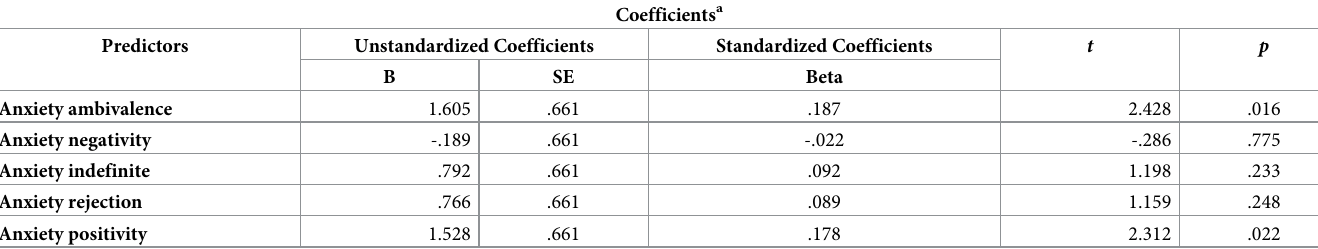
Table 11. Anxiety script: Multiple regression analysis; script’ factors predict trait